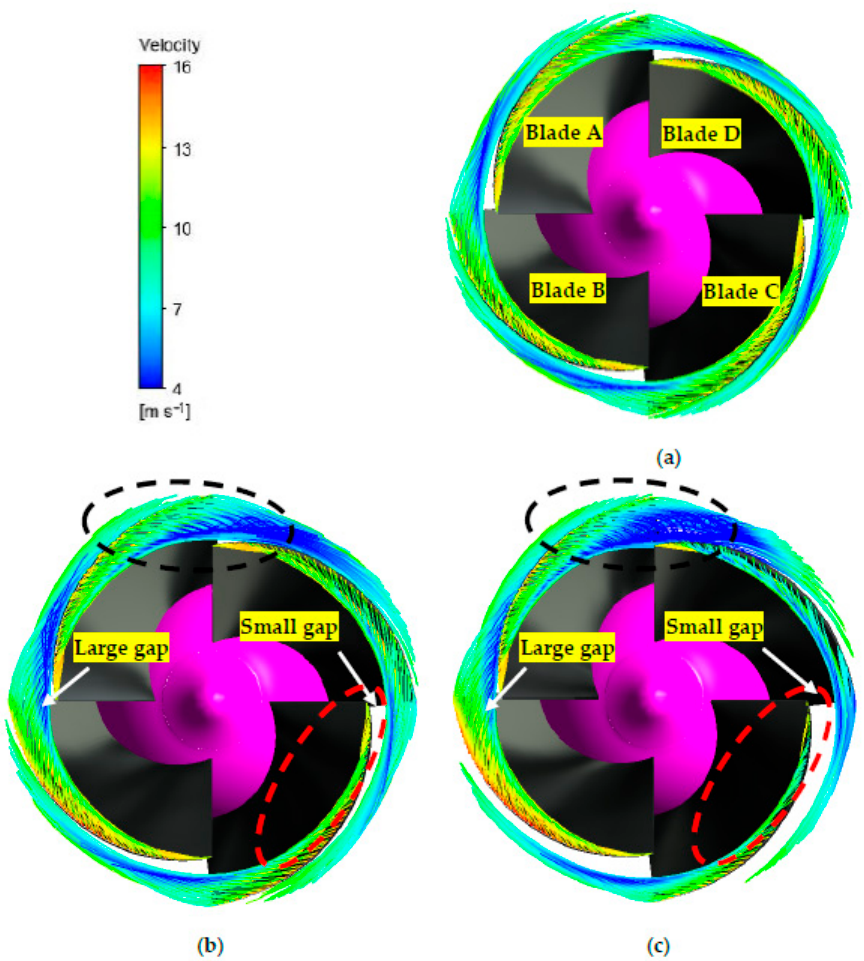
Figure 11. Three − dimensional streamline of tip region under different eccentricities. ( a ) e = 0 mm; ( b ) e = 0.3 mm; ( c ) e = 0.5 mm.